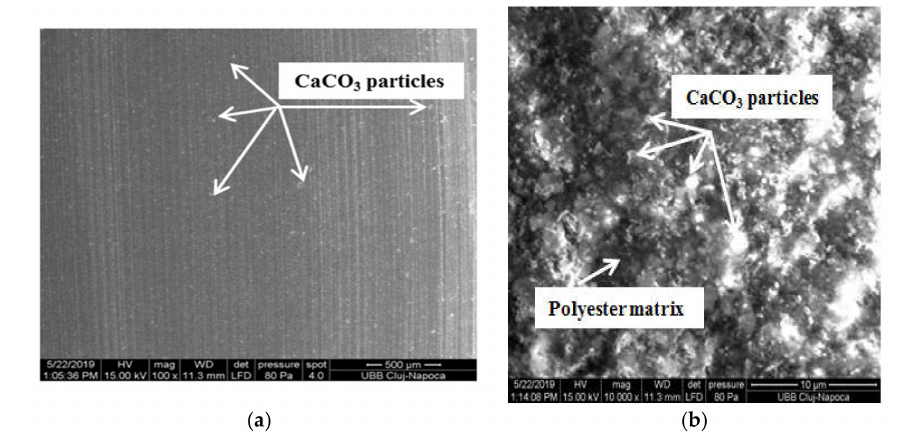
Figure 17. Scanning electron microscopy (SEM) images of composite 1: ( a ) 1:5 × 10 − 4 m scale ( b ); 1:1 × 10 − 5 m